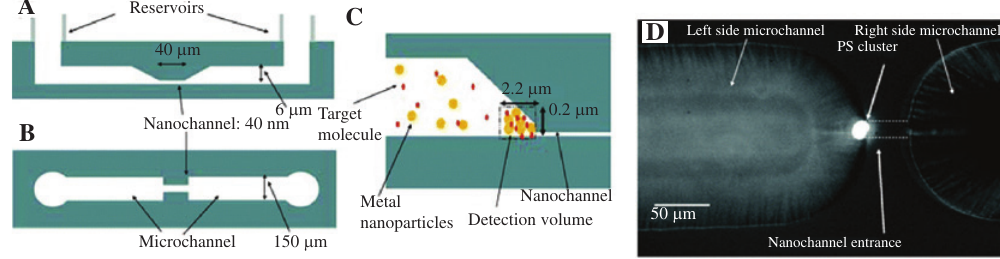
Figure 9: Schematic diagram of an optofluidic device: (A) side view, (B) top view, (C) side view of an optofluidic device with aggregated nanoparticle-SERS active clusters at the step structure. The depth of nanochannel is smaller than that of nanoparticles. Thus, nanoparticles are trapped and aggregated. (D) Fluorescent image of polystyrene nanoparticles trapped at the step boundary of the optofluidic device. Reprinted with permission from [184]. Copyright 2007 American Chemical Society.